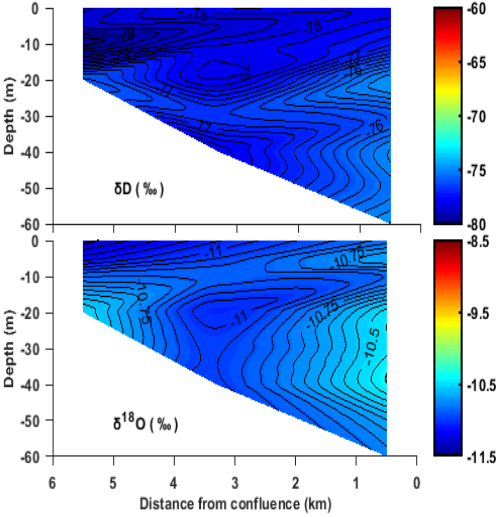
Figure 8. Spatial variation of the δ D and δ 18 O in the Zhuyi Bay during the dry season.